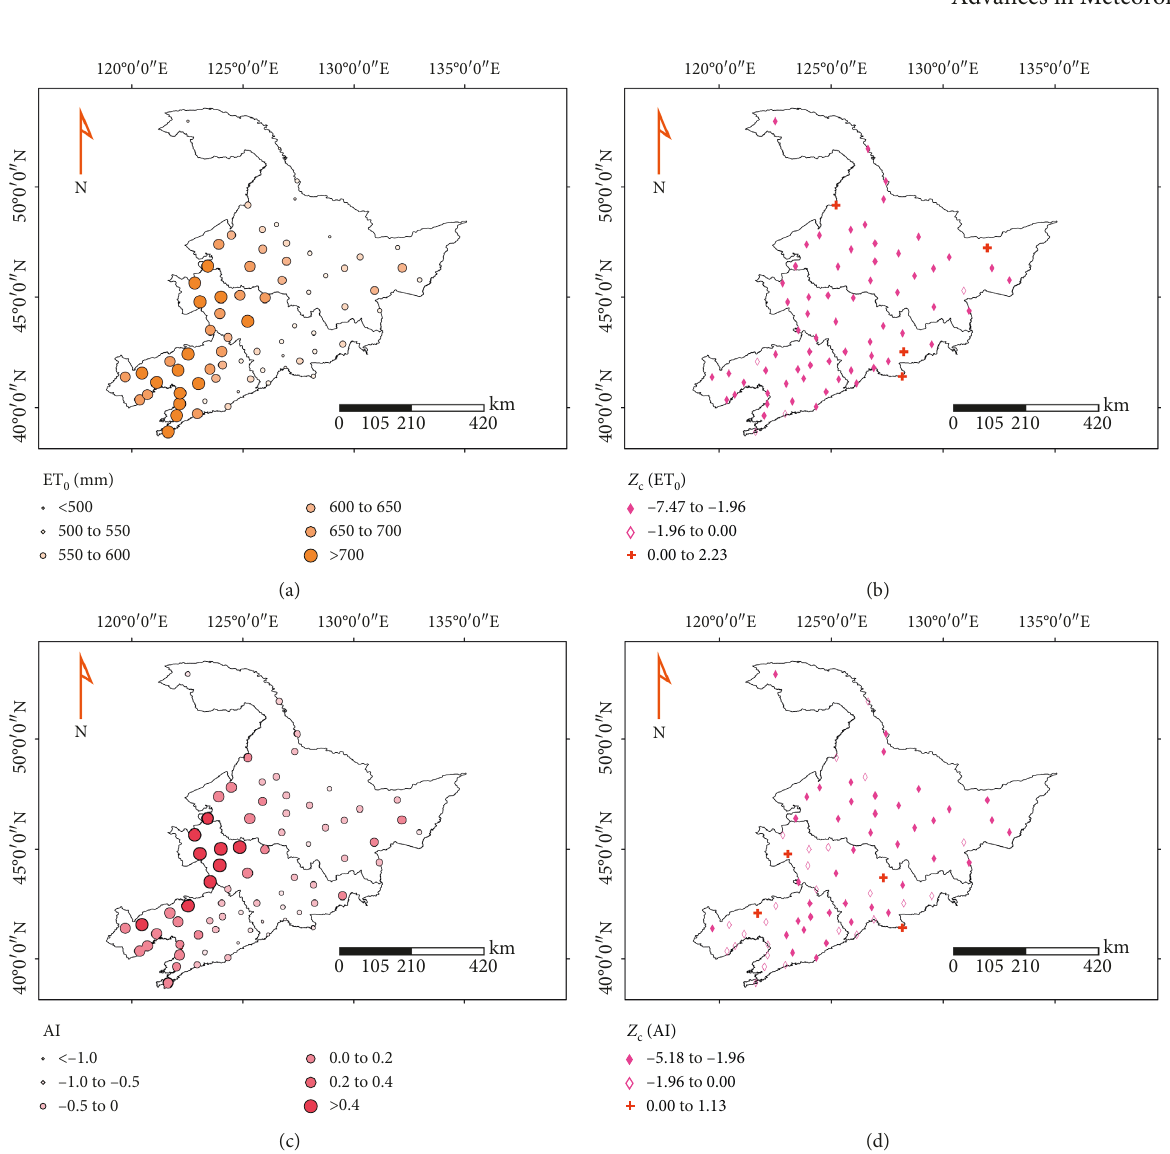
0 (a, b) and AI (c, d) over the study area from 1965 to 2017.